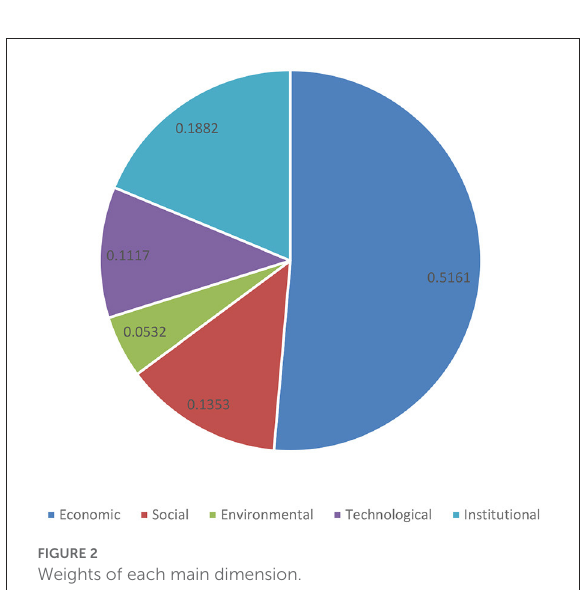
FIGURE2 Weights of each main dimension.